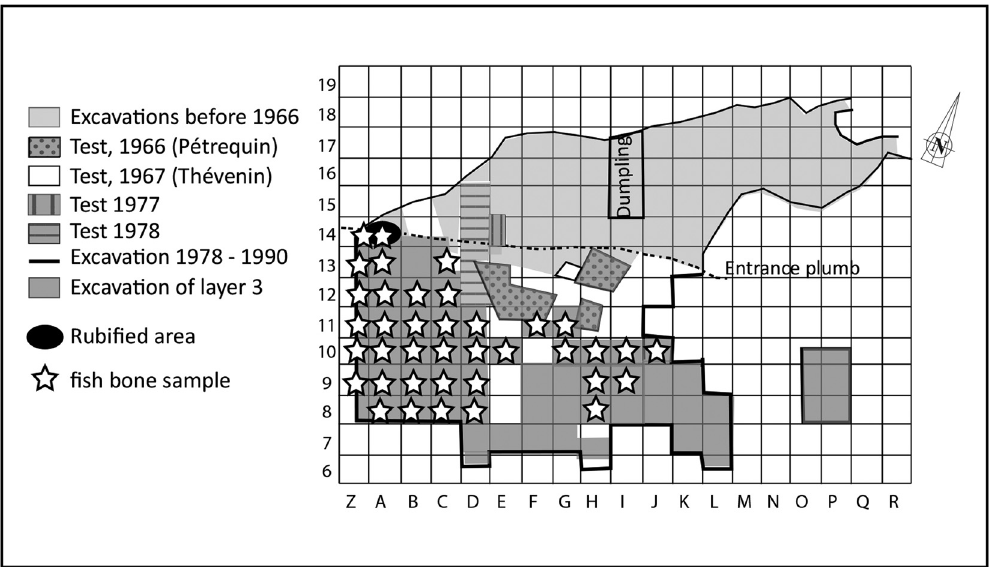
Figure 4: Excavation map of Les Cabônes shelter at Ranchot and sampling location of analysed fi sh remains from Layer 3; scale: a square represents 1 m 2 . CAD A. Bridault, modi fi ed from Leduc and Carquigny ( Leduc et al., 2015 )